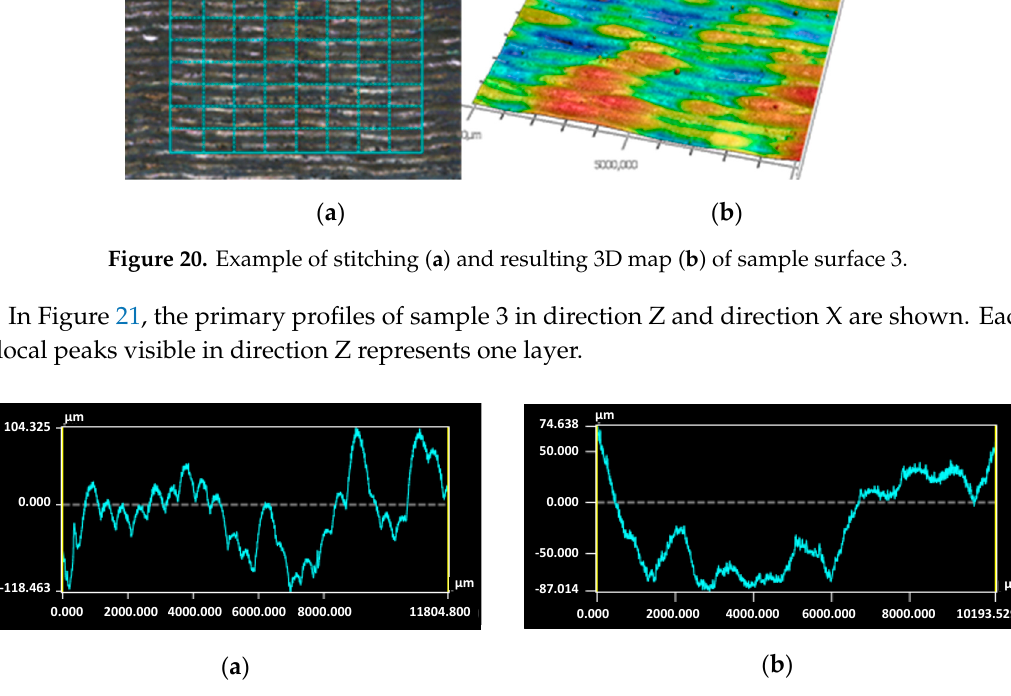
Figure 21. Primary profile of sample 3; ( a ) direction Z, ( b ) direction X.